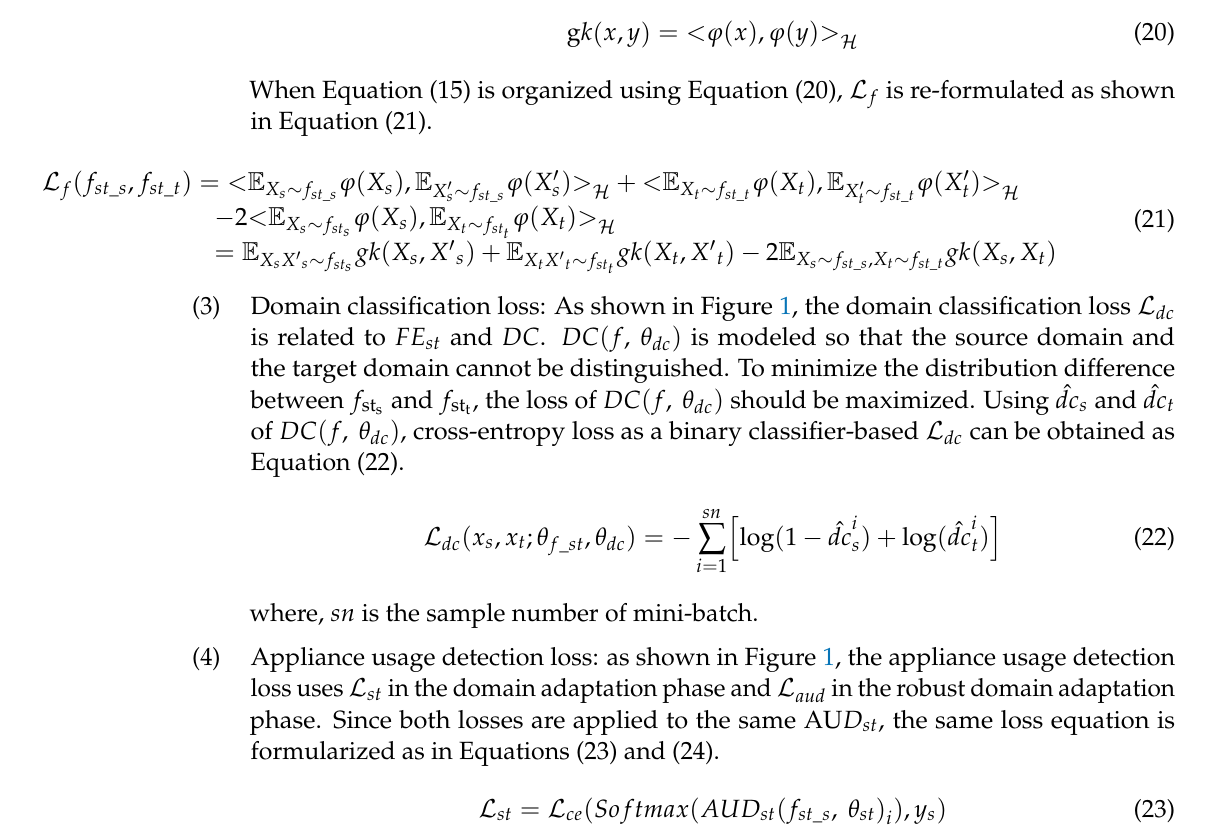
Appliance usage detection loss: as shown in Figure 1, the appliance usage detection loss uses L st in the domain adaptation phase and L aud in the robust domain adaptation phase. Since both losses are applied to the same AU D st , the same loss equation is formularized as in Equations (23) and